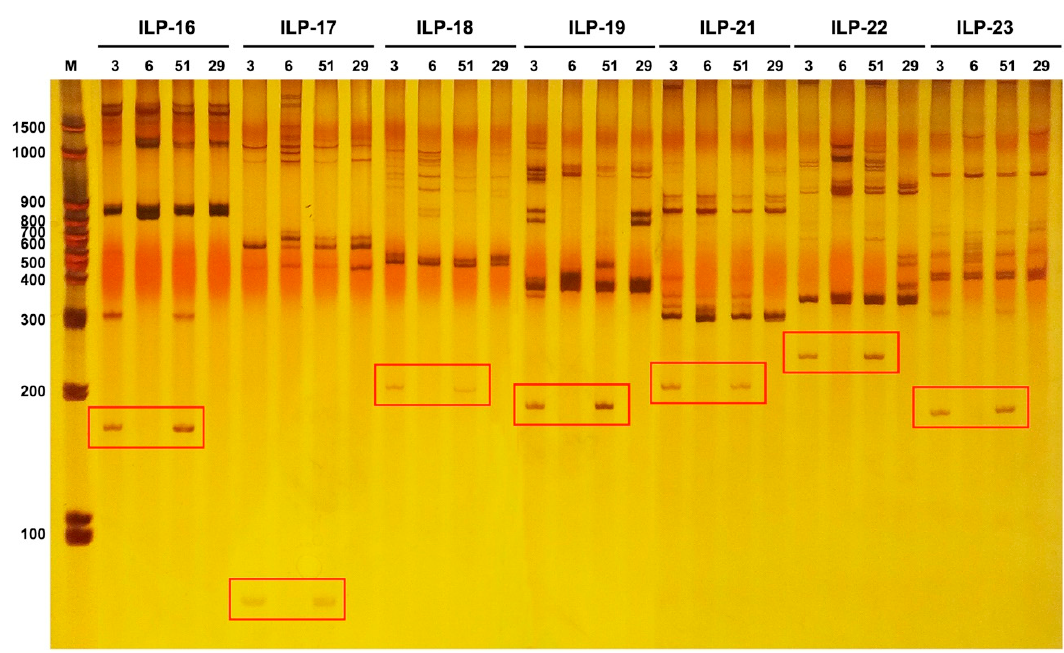
Figure 5. Detection of intron losses in IbGBSS1-1 . The intron losses in IbGBSS1-1 genes were detected in four sweet potato germplasms using the ILP markers shown in Table 4. M, marker. The numbers 3, 6, 51, and 29 represent the sweet potato germplasms shown in Supplementary Materials Table S1,